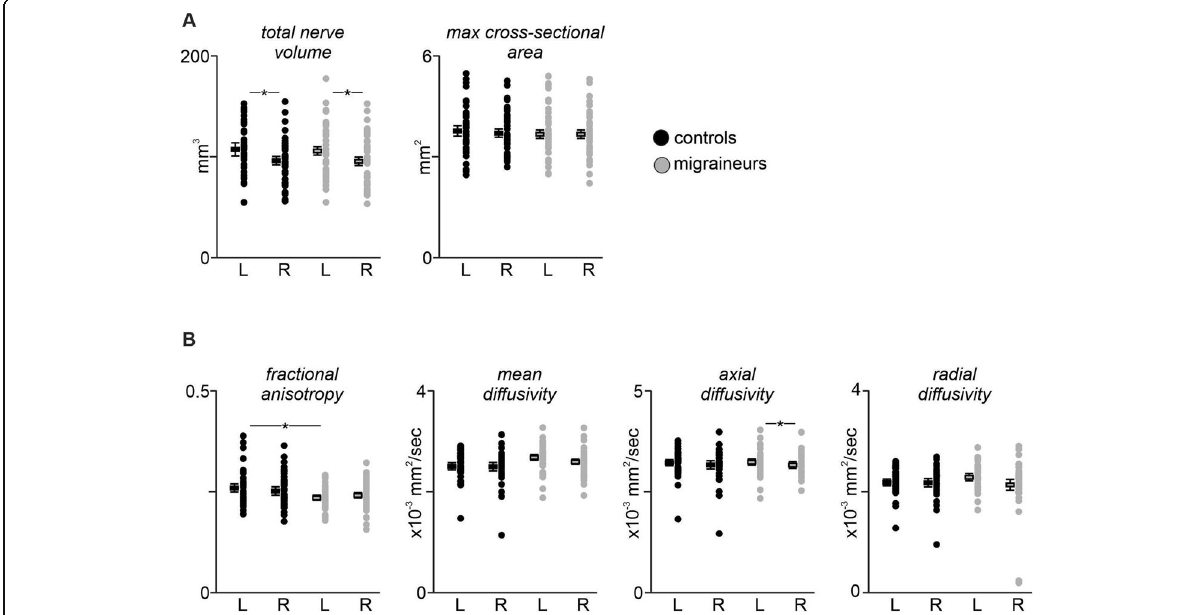
Fig. 2 a Plots showing left and right nerve volumes and maximal cross-sectional areas in individual controls (black shading) and migraineurs (grey shading). Horizontal box plots indicate mean (±SEM) for the left and right nerves of each group. Note that only the volume was significantly different, i.e., lower in the right nerve for both controls and migraineurs. * p < 0.05. b Plots showing fractional anisotropy, mean diffusivity, axial diffusivity and radial diffusivity of the left and right trigeminal root in individual controls and migraineurs. Horizontal box plots indicate mean (±SEM) for the left and right nerves of each group. Note that only fractional anisotropy (FA) and axial diffusivity (AX) was significantly different, i.e., FA was lower in the left nerve of migraineurs than controls and AX was lower in the right nerve than the left nerve in migraineurs. * p <